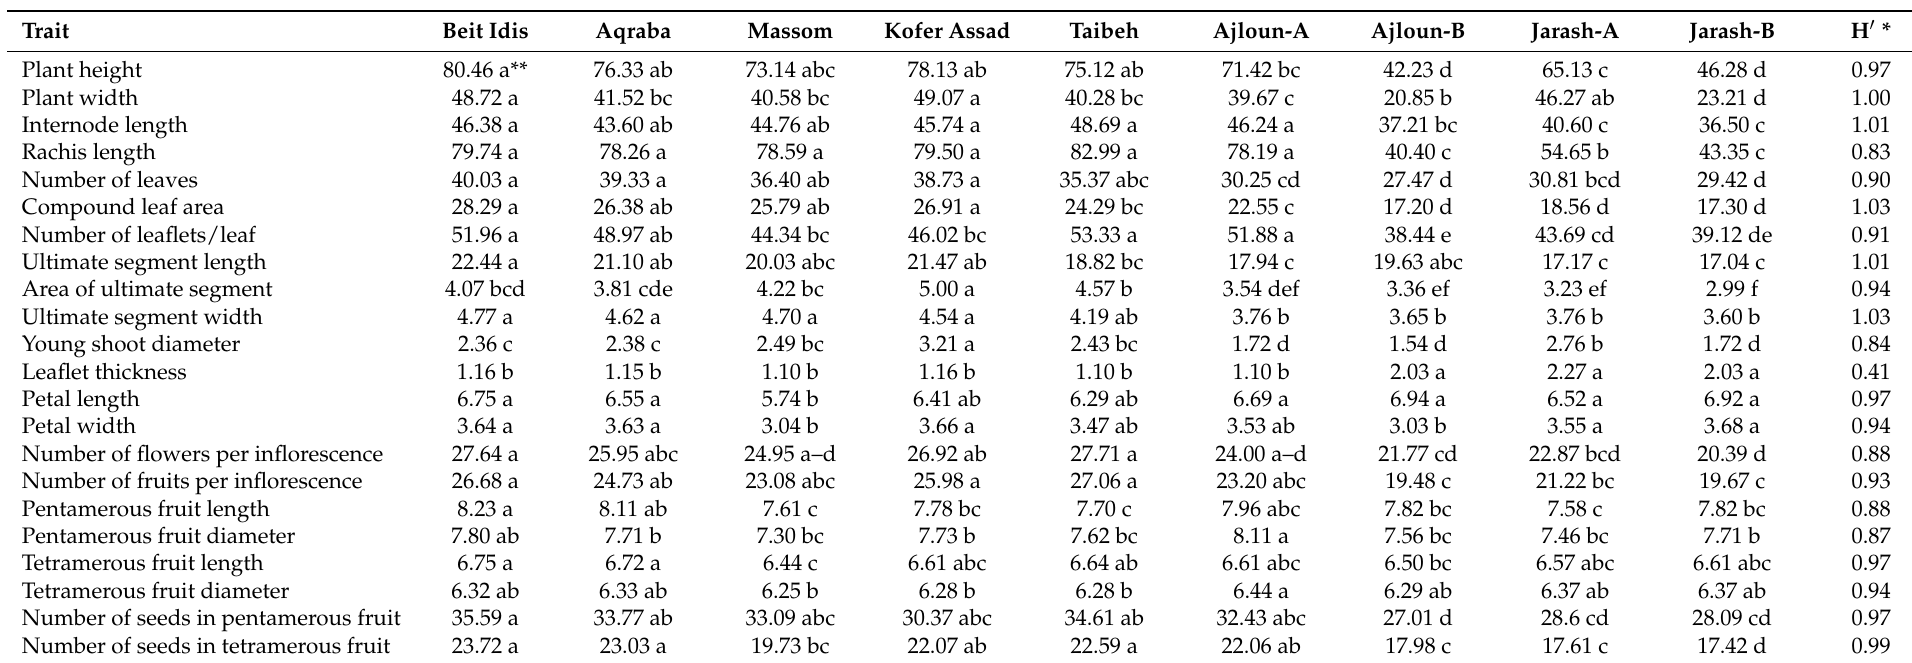
Table 3. Mean values of 22 morphological traits and Shannon diversity index for each trait analyzed in nine R. chalepensis populations collected from northern